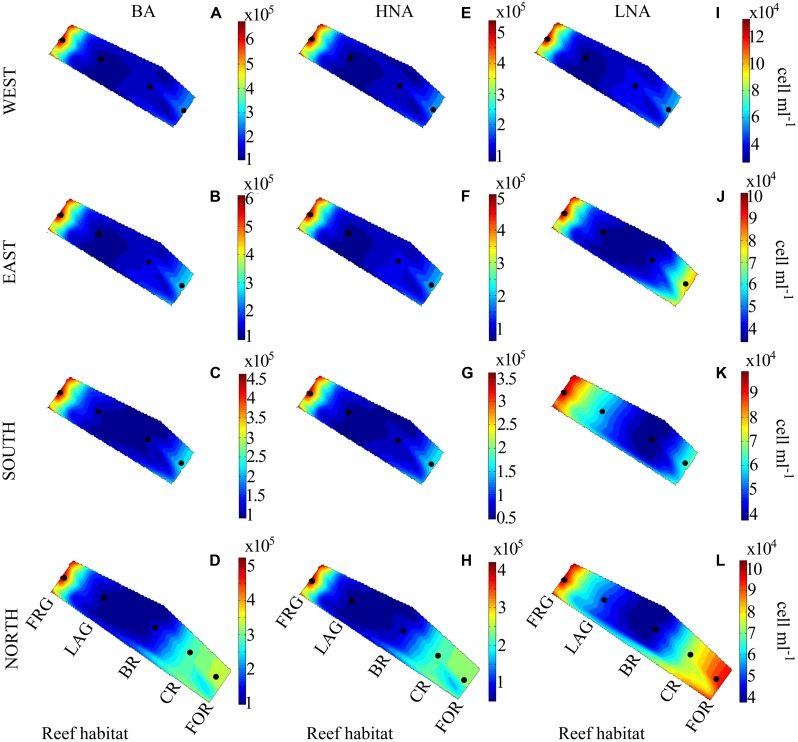
Spatial distribution of heterotrophic bacteria along four regional transects (east, west, south, and north) surrounding Moorea. (A–D) Bacterial abundance (BA), (E–H) high nucleic acid (HNA) bacterial abundance and (I–L) low nucleic acid (LNA) bacterial abundance. Each transect crossed distinct reef habitats: the fringing reef (FRG), lagoon (LAG), back reef (BR), crest (CR), and fore reef (FOR). Note the FOR was sampled only on the north transect. Black dots indicate the relative position of the samples collected. Contour plots indicate the mean values of duplicate samples.